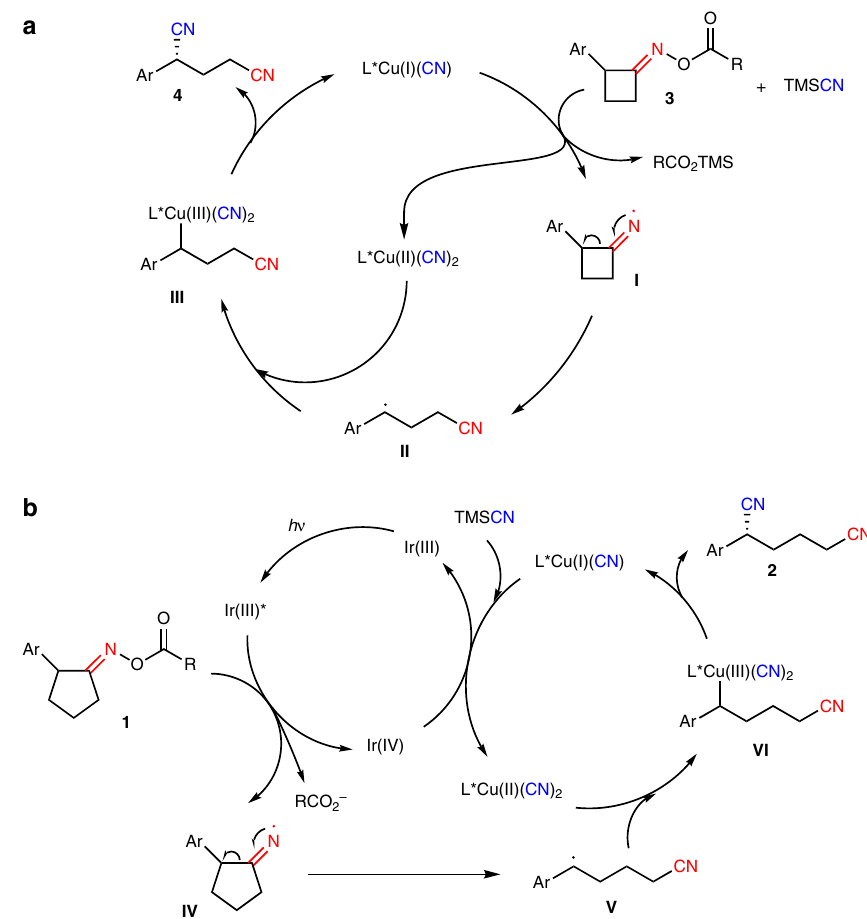
Fig. 6 Proposed mechanisms. a copper catalysis. b a dual photoredox/copper